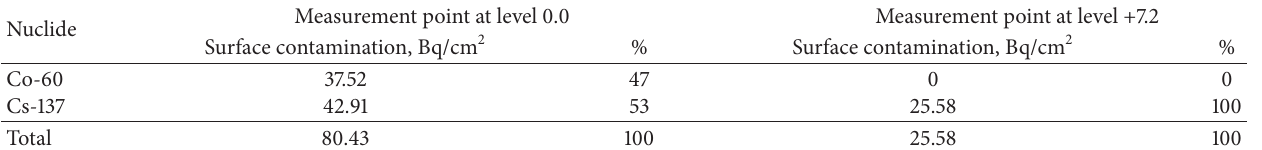
Table 2: Contamination of internal surfaces of ECCS PT